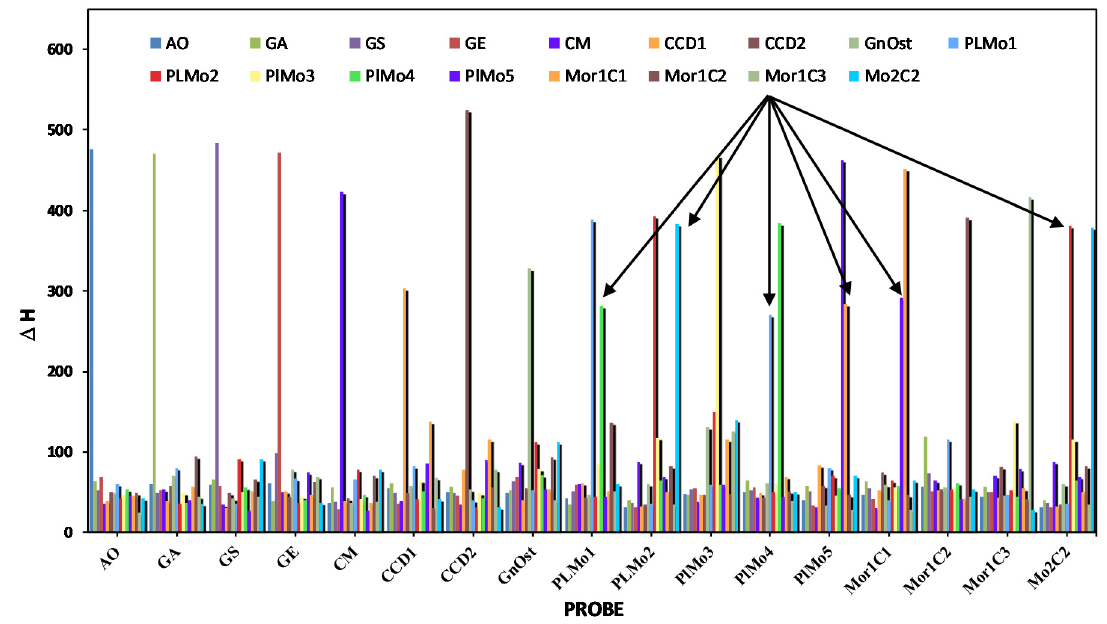
Figure 3. Plot of the enthalpy values needed to denature pairs of probes and targets.